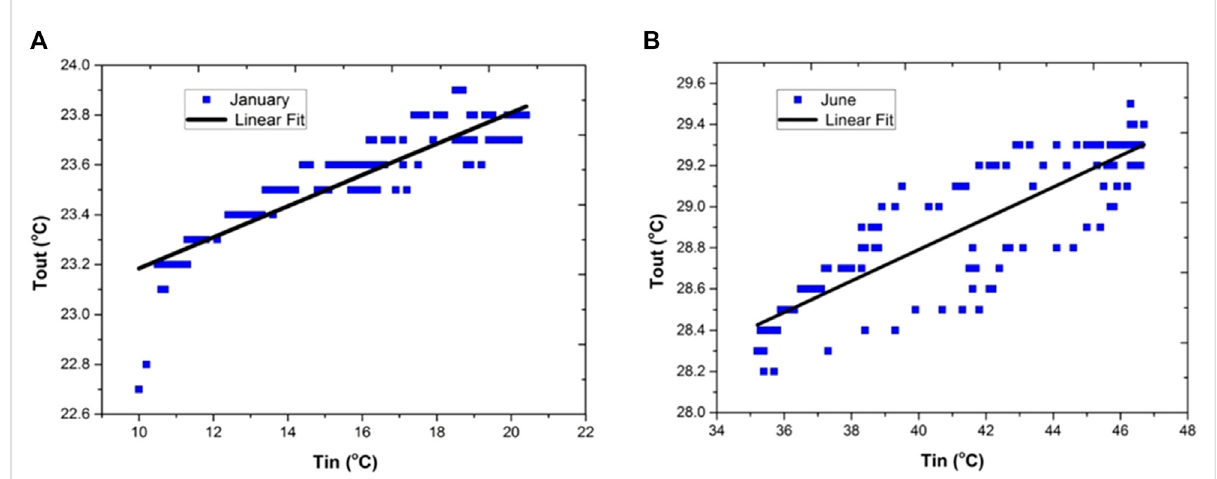
FIGURE 9 Variation of outlet temperature with inlet temperature during (A) January and (B) June.